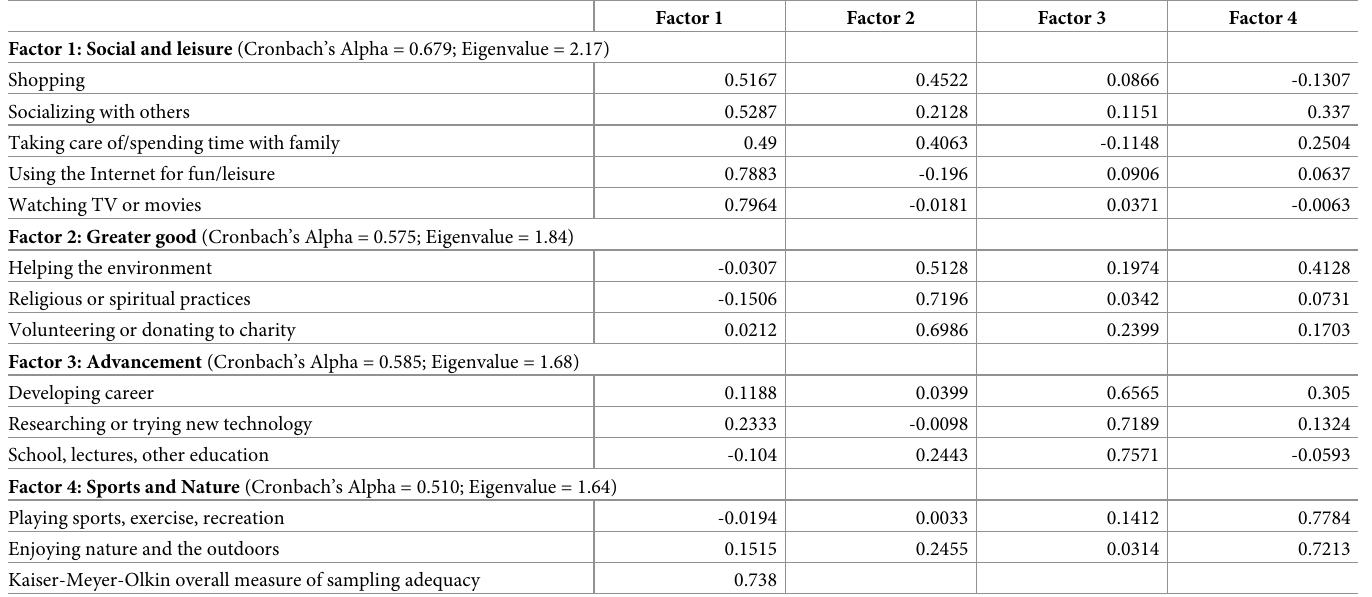
Table 2. Principal component factor analysis results for lifestyle survey questions.